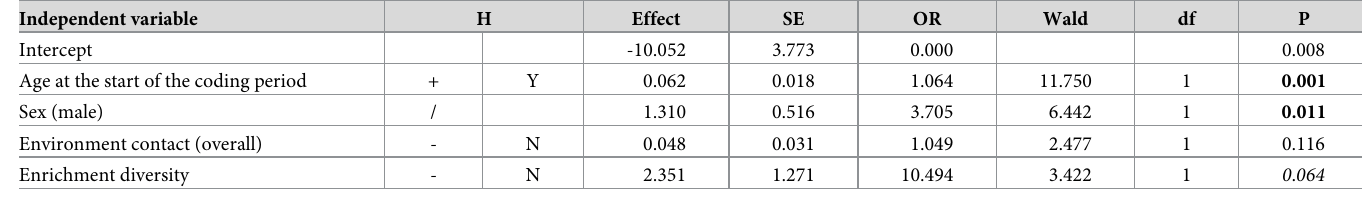
Table 14. Multivariate assessment of the occurrence of lameness/stiffness by binomial regression, counting each animal as having experienced (n = 80) or not (n = 132) this type of pathology. Hypotheses (H): positive (+) or negative (-) relationship of each variable with the occurrence of clinical events per animal as a measure of elephant welfare, and whether observed relationships were in the predicted direction (Y yes / N no).